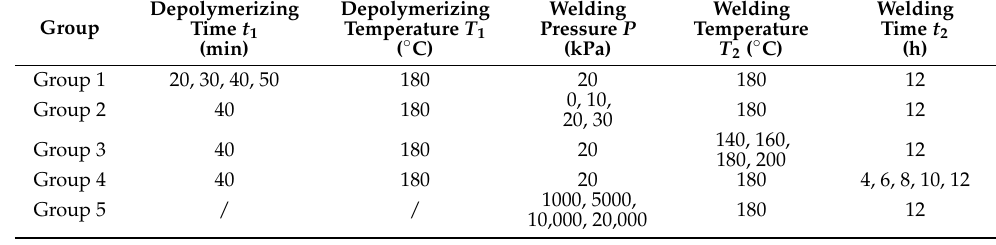
Figure 2. Schematic of the solvent ‐ assisted welding process of epoxy vitrimer: ( I ) original epoxy